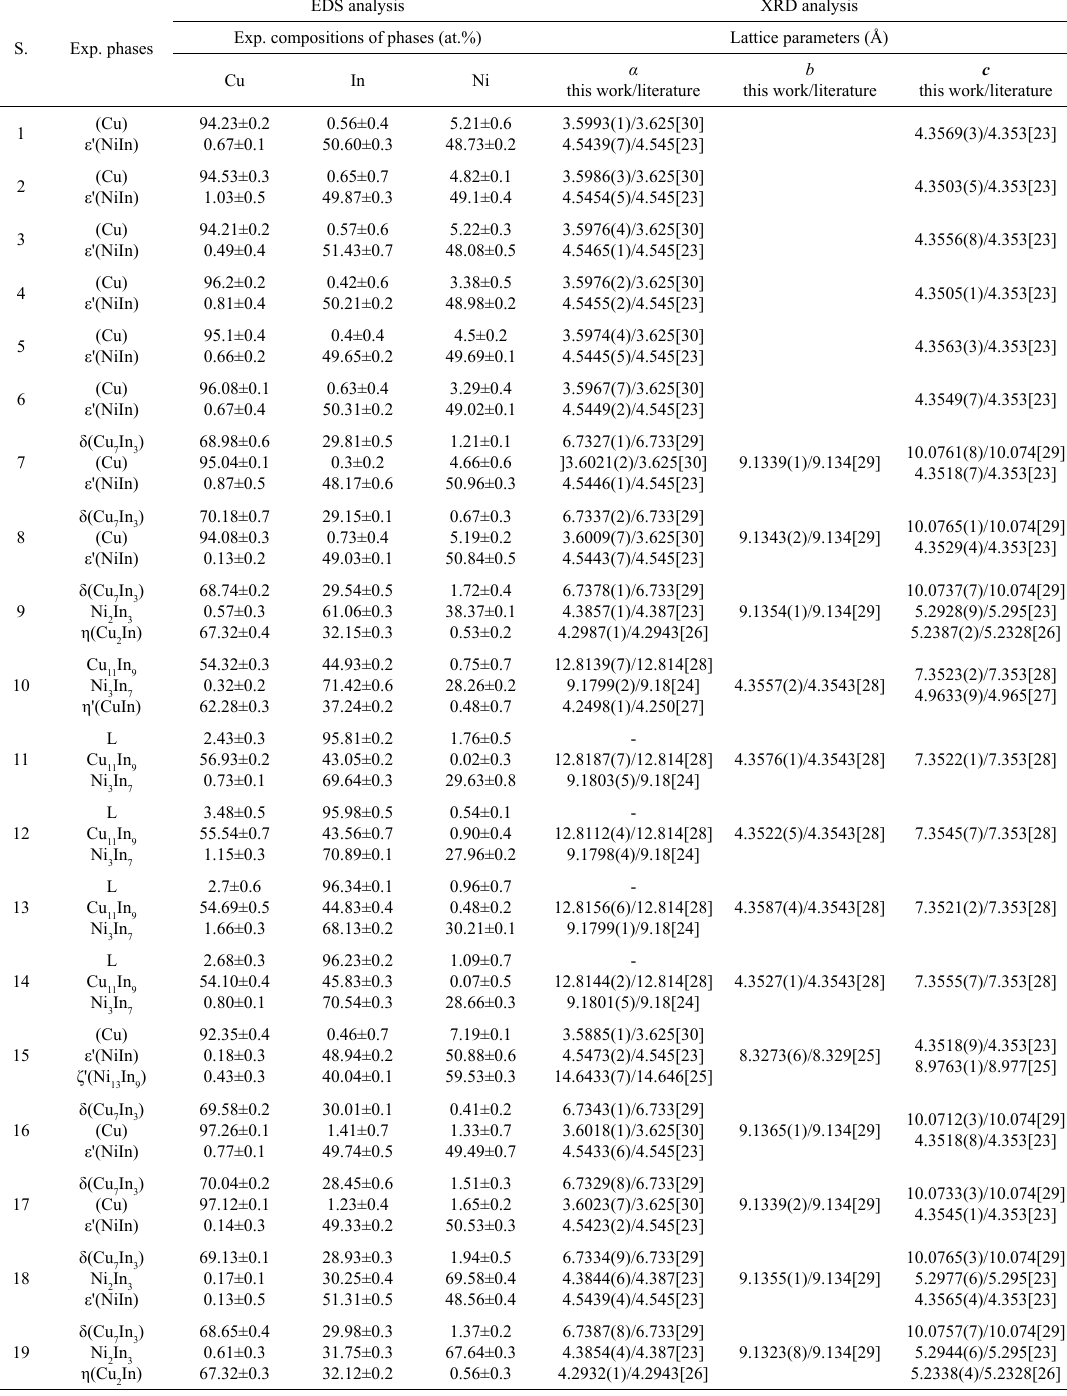
Table 2. Experimentally determined phase compositions and lattice parameters of phases in the ternary Cu–In–Ni system at 300 ºC